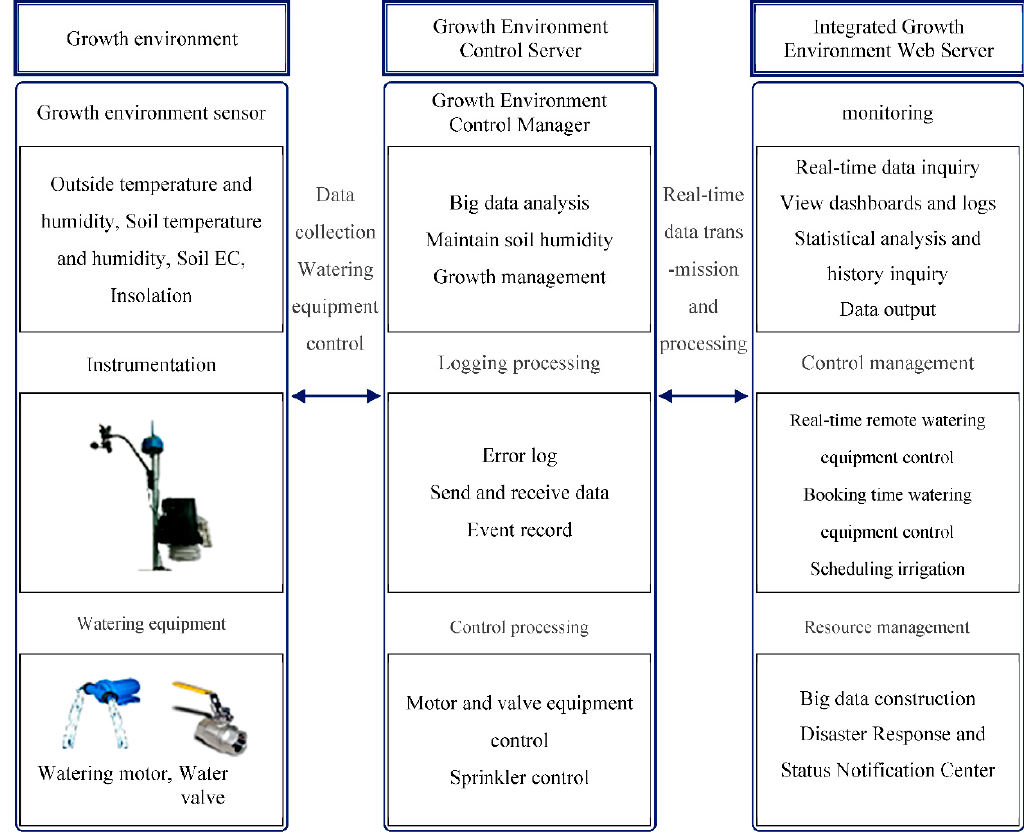
Figure 10. Smart-farming-system diagram.